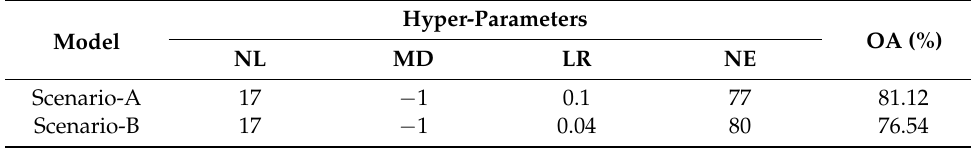
Table 3. Hyper-parameters of the model and the overall accuracy of the training dataset.